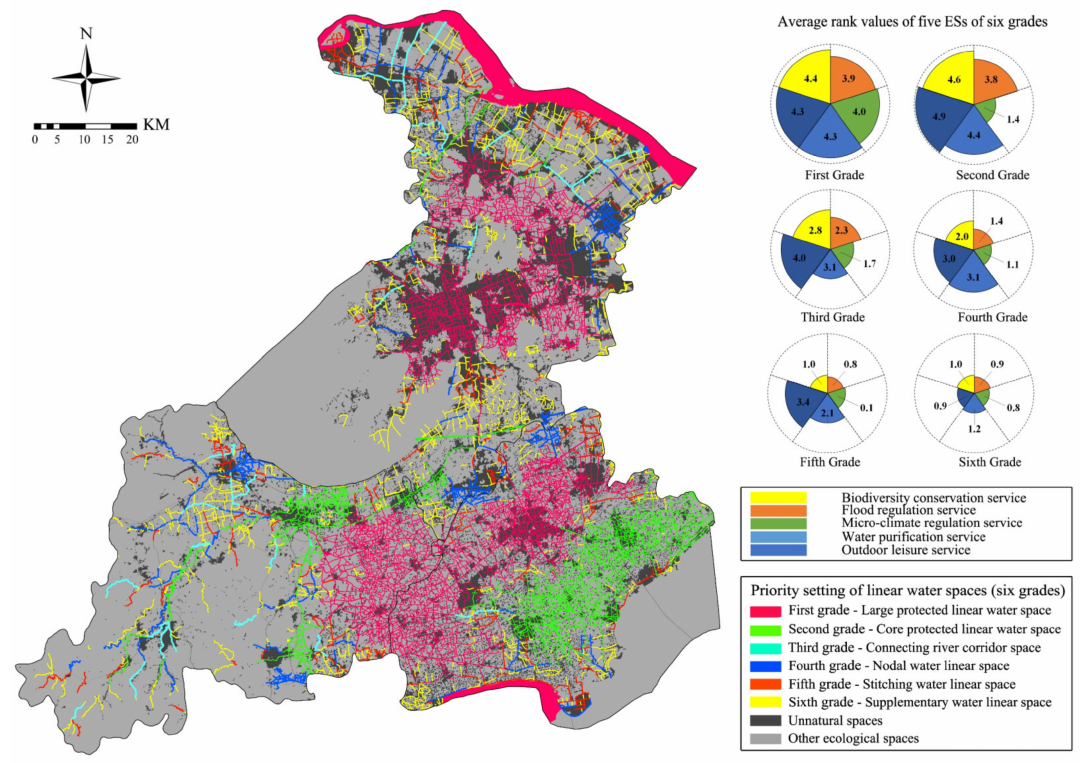
Figure 7. Six priority grades of linear water spaces in the Hu-Su-Jia